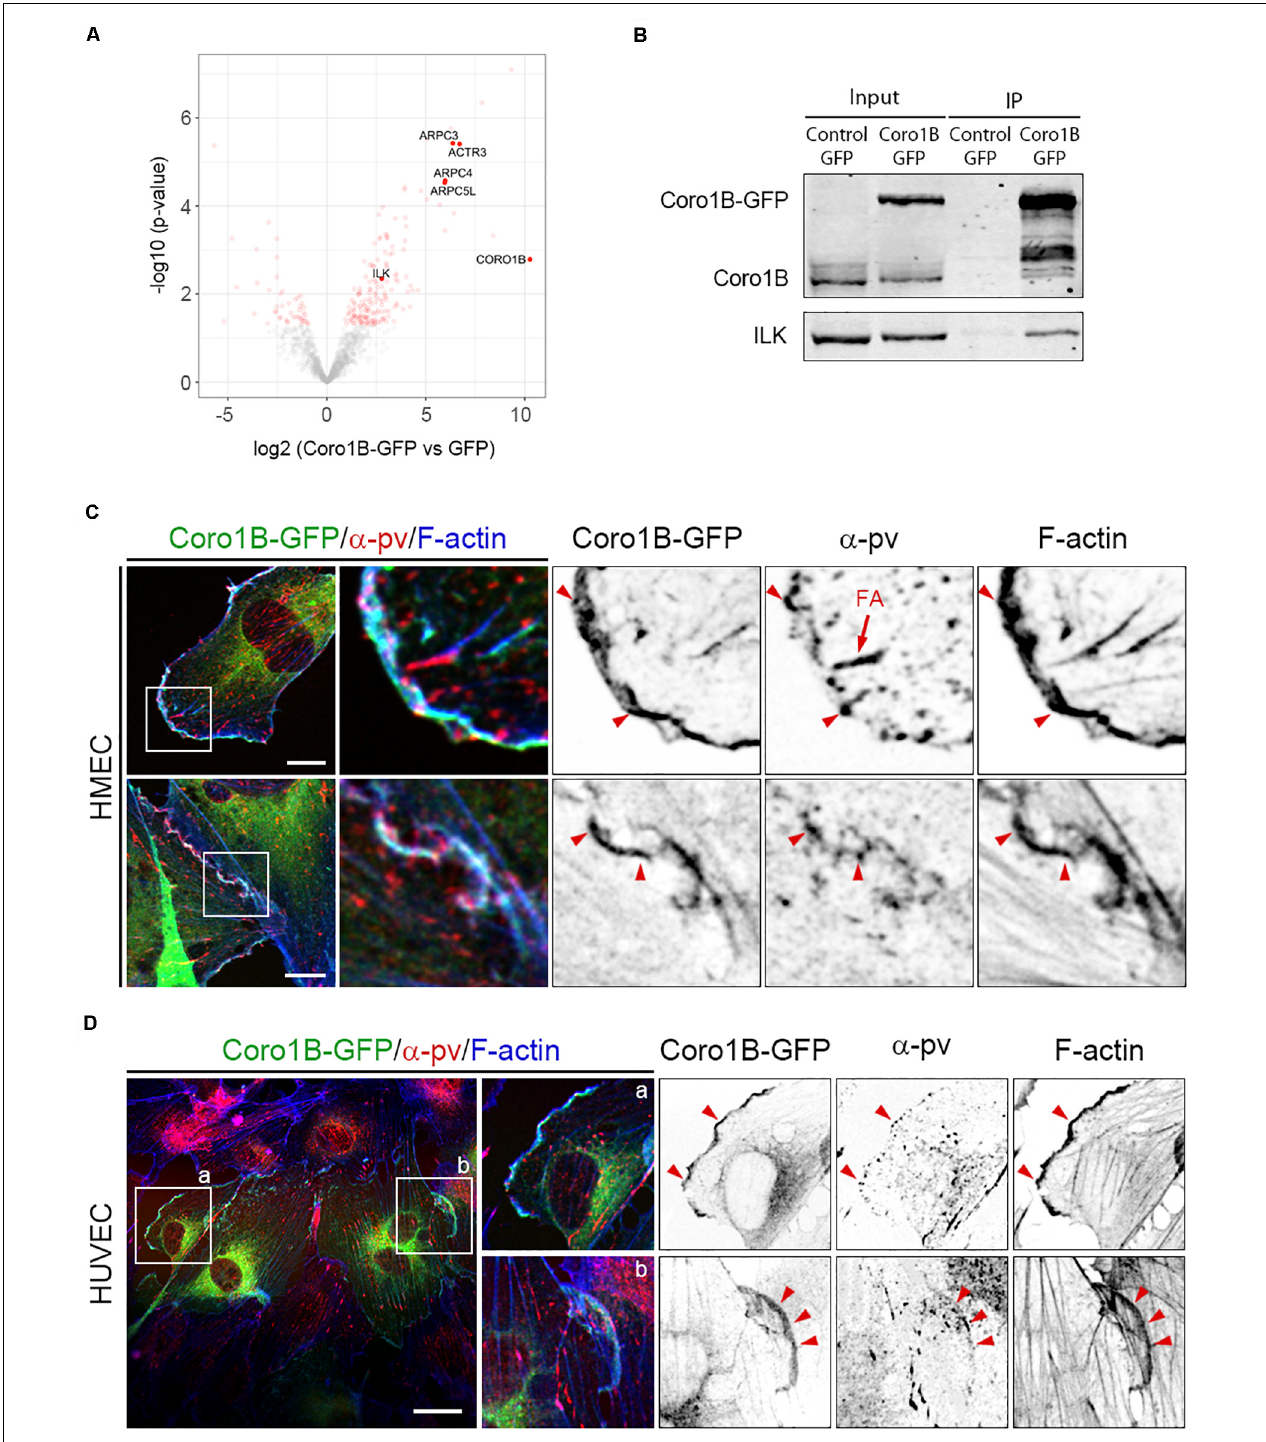
FIGURE 4 | ILK is a new Coro1B-interacting protein. (A) Volcano plot showing the log2 fold enrichment of the proteins identified by label-free mass spectrometry in immunoprecipitates from Coro1B-GFP HMECs compared to the GFP control HMECs and the p -value (–log10) of the adjusted t -test comparing the abundance of these proteins in both immunoprecipitates. Proteins with a log2 fold enrichment above 2.0 and a p -value below 0.05 were considered significant ( n = 4, see Supplementary Table S1 ). (B) Coro1B-GFP immunoprecipitation of ILK in Coro1B-GFP expressing HMECs. GFP expressing HMECs were used as a control. Whole-cell lysates are shown as the input. Coro1B-GFP expressing (C) HMECs and (D) HUVECs transfected with Coro1B-GFP (green) and stained for α -pv (red) and F-actin (blue). Arrowheads point to Coro1B-GFP, α -pv and F-actin colocalization. FA (arrow): focal adhesions. Scale bar = 25 µ m.